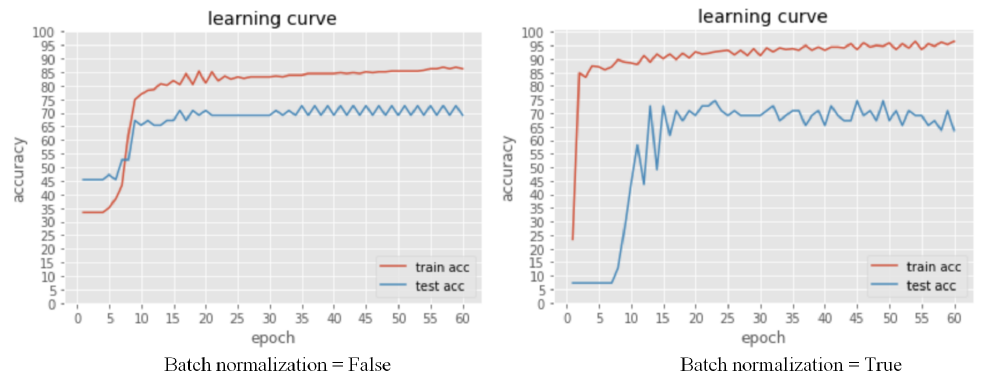
Figure 5. The accuracy of train and test dataset under different batch normalization (hidden layers = 5, Neurons in each layers = (25, 200, 400, 300, 100, 50, 3)).